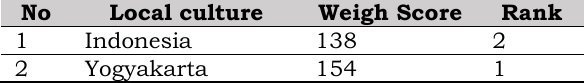
Table 3. Students’ preference for local